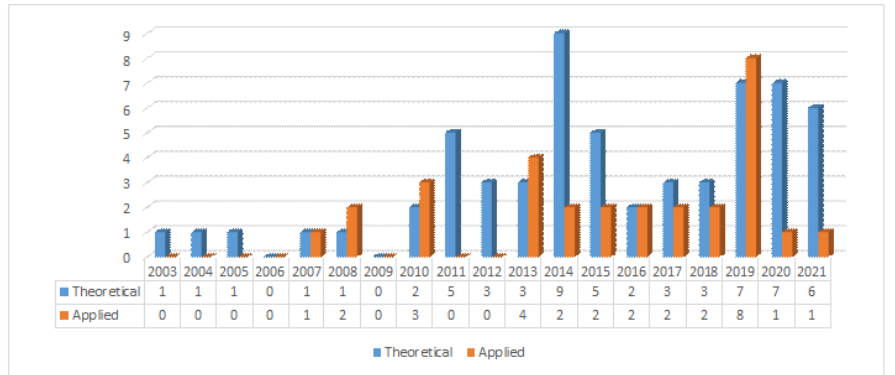
Figure 3. Road curb detection publications over time. Publications are organized into Theory (contributed method) and Applications.